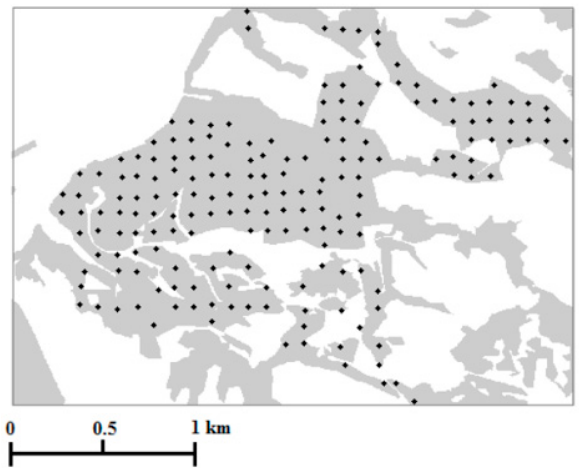
Figure 3. Distribution of 184 selected inventory plots overlaid on the forest mask which was manually digitized from WorldView-2 data, where black pixels represent the center of each plot and the forest mask is shown in light grey color.